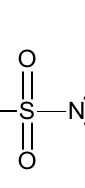
Figure 1. General structure of sulphonamides; R=R1=H for sulphanilamide.